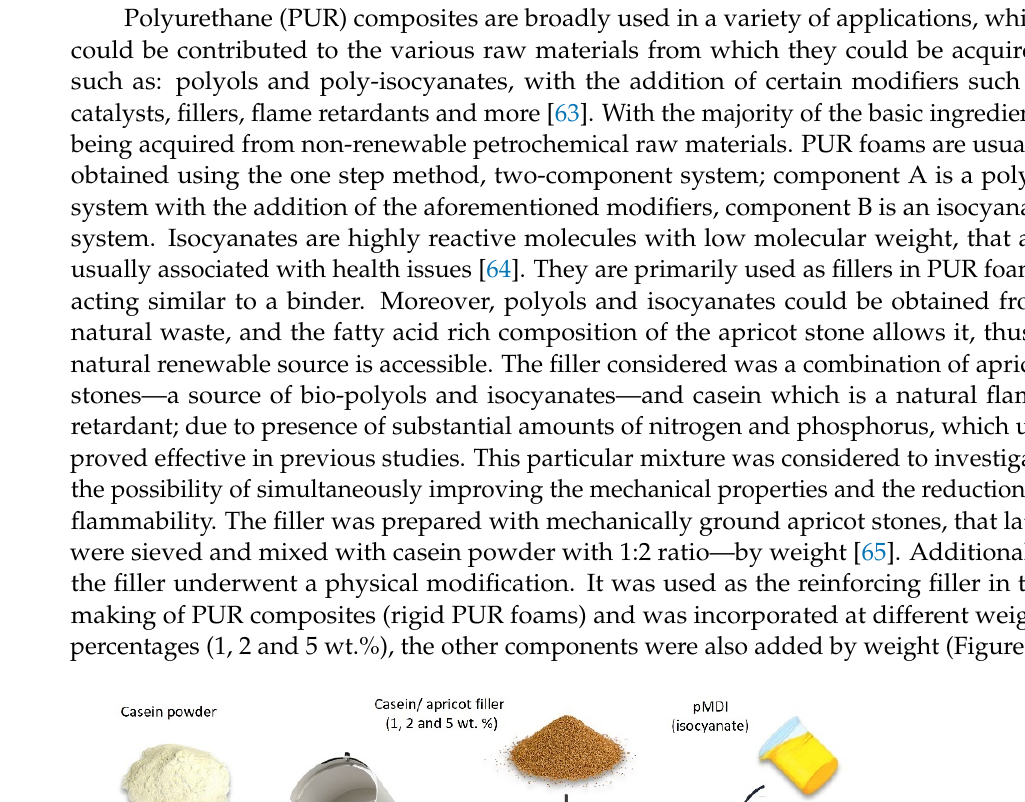
Figure 6. Chitosan films incorporated with AKEO [62].